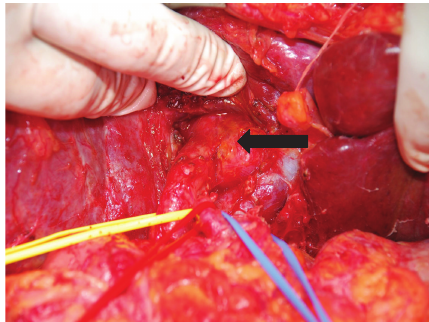
Figure 3: Intraoperative picture showing tumor arising from the left hepatic duct. CBD hooked in yellow, hepatic artery in red, and portal vein in blue.